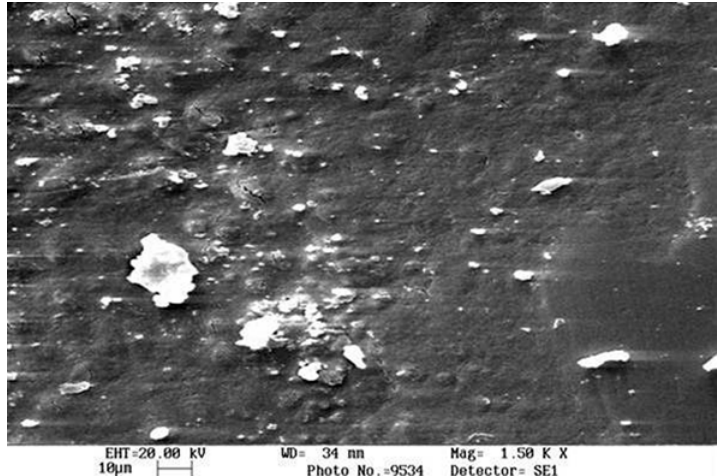
FIGURE 5- SEM micrograph of enamel subjected to bleaching agent containing 10% carbamide peroxide (Platinum), presenting erosions (×1,500)